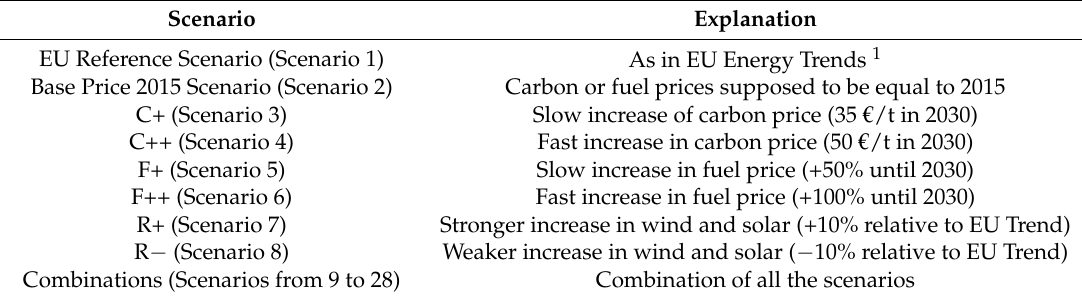
Table 1. Price scenarios used in this work, according to [36].